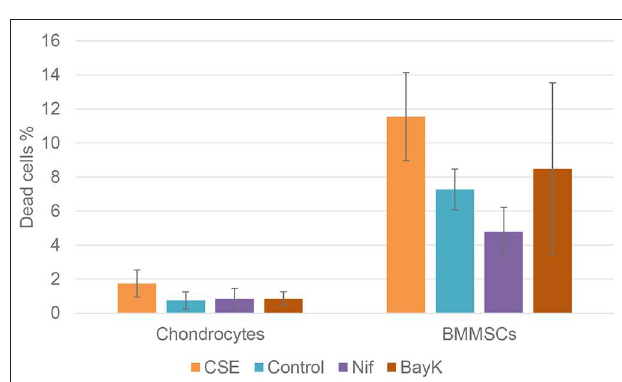
FIGURE 9 | Nitric oxide (NO) activity in chondrocytes and BMMSCs. Treatment with cigarette smoke extract (CSE) (1 µ g/mL), DMSO (Control), nifedipine (10 µ M) (Nif), BayK8644 (10 µ M) (BayK) for 24h. Horizontal bars represent p < 0.05.